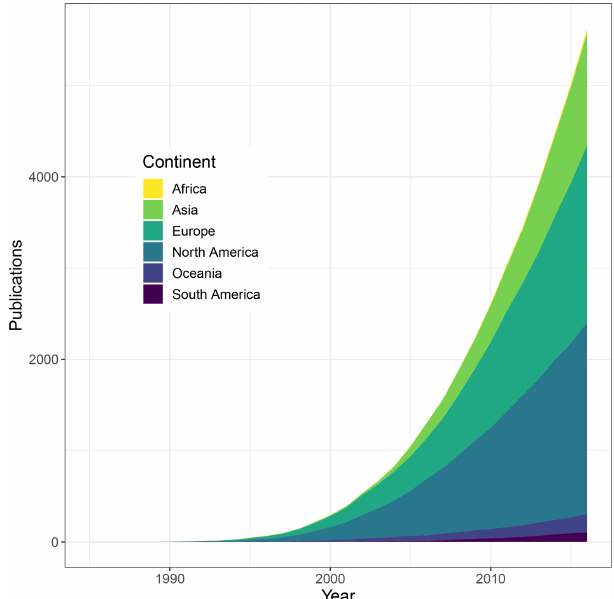
Figure 4. Cumulative numbers of publications on eddy covariance (EC) flux research conducted in different regions from 1985 to 2016. Data source: Dai et al.